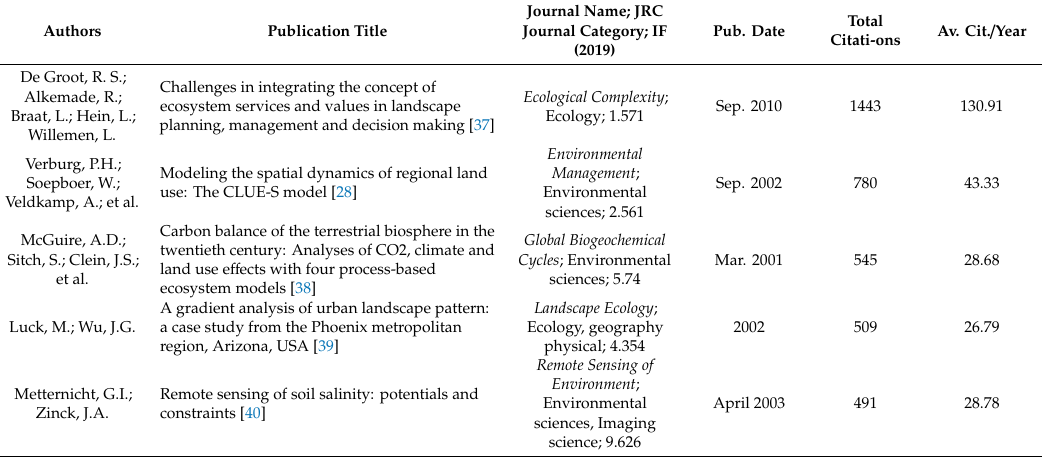
Table 4. Highly cited papers (more than 200 citations) referred to GIS spatial analysis modeling for land use